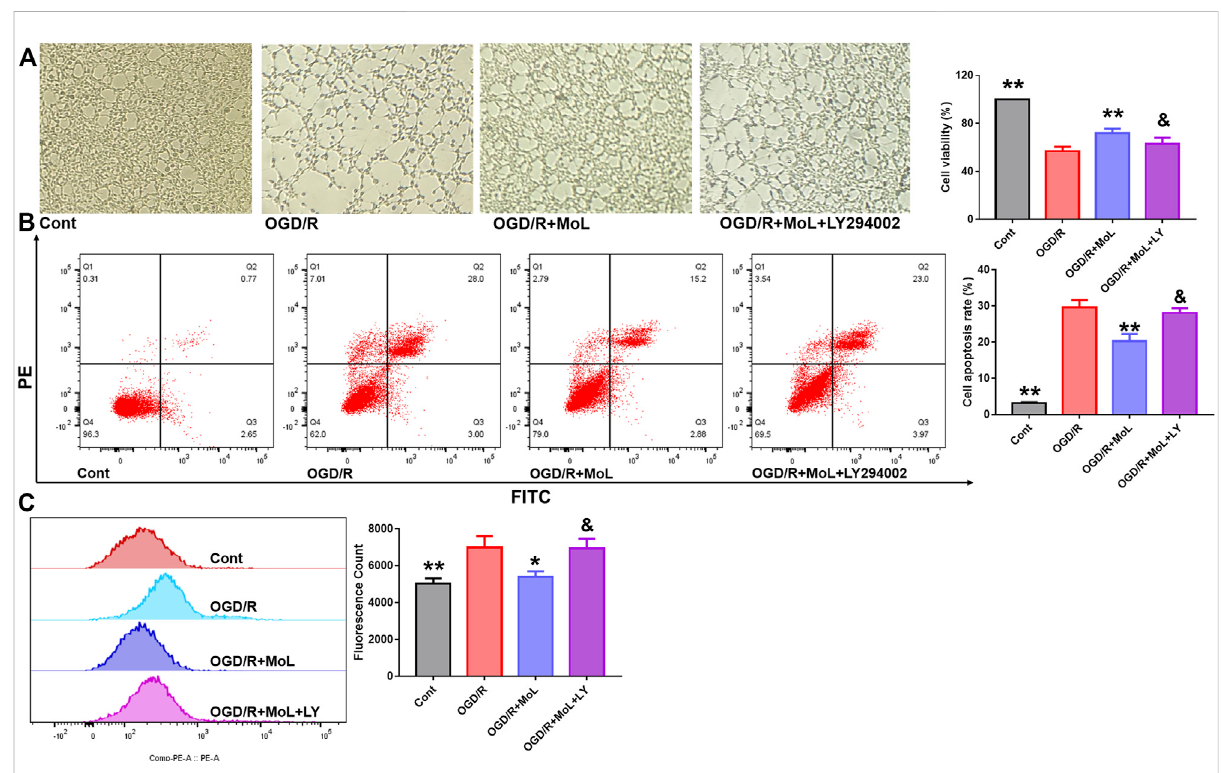
FIGURE 9 MOL can partially inhibit OGD/R-induced apoptosis and oxidative stress in SHSY-5Y cells by activating PI3K/AKT pathway. (A) The PI3K/AKT pathway inhibitor LY294002 (10 μ M) prevented MOL (20 μ M) from saving the viability of OGD/R-treated SHSY-5Y cells; (B) LY294002 (10 μ M) inhibited the anti-apoptotic effect of MOL (20 μ M) on OGD/R-treated SHSY-5Y cells; (C) LY294002 (10 μ M) inhibited the anti-ROS effect of MOL (20 μ M) on OGD/R-treated SHSY-5Y cells. Data expressed as Mean ± SD, ** p < 0.01, * p < 0.05 vs. OGD/R